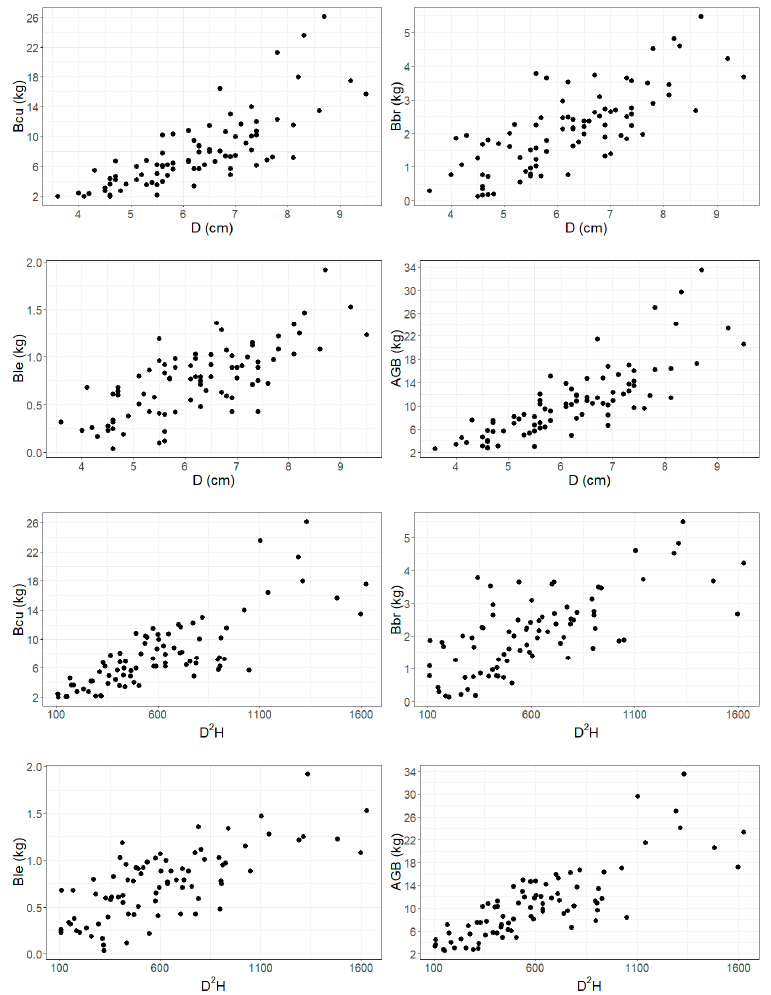
Figure 3. Scatterplots of biomass of culm ( Bcu , kg), branches ( Bbr , kg), leaves ( Ble , kg), and bamboo aboveground biomass ( AGB , kg) versus diameter ( D ) and D 2 H = D 2 (cm) × H (m).